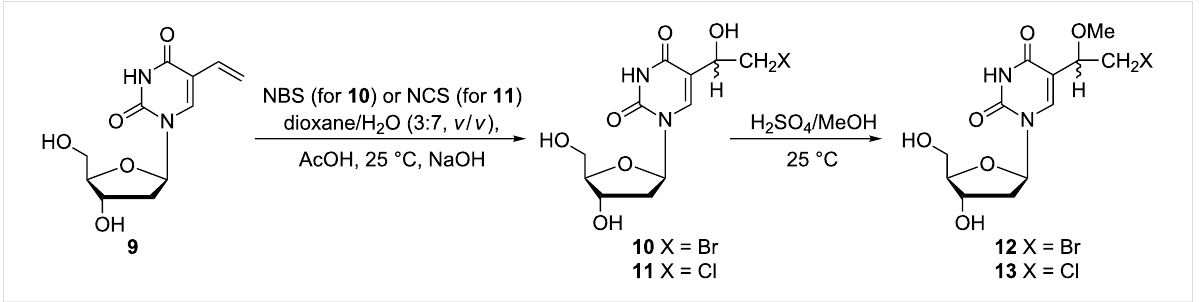
activity. In 1989 Kumar and co-workers reported, amongst other things, two 5-(1-methoxy-2-haloethyl)-2'-deoxyuridines 12 and 13 (Scheme 3)